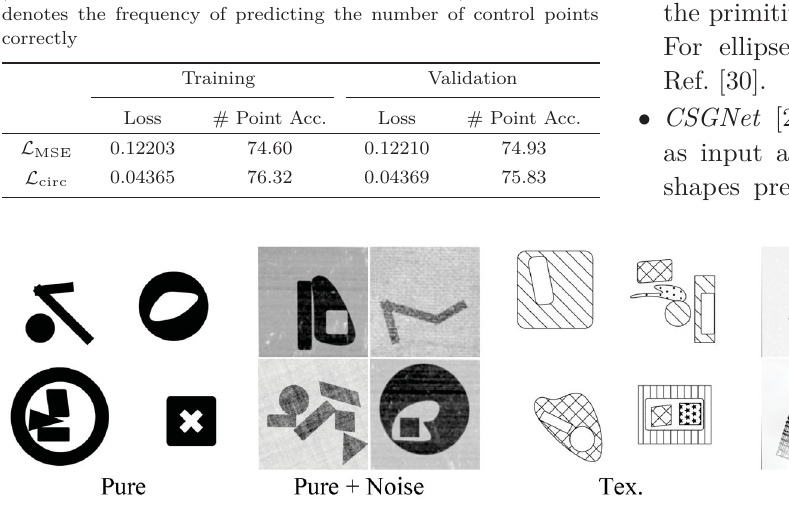
Fig. 3 Examples drawn from our synthetic training dataset. For the Pure dataset, we synthesized simple binary images for training. The Pure+Noise dataset modified the Pure dataset by adding noise and random affine transformations to each image. The Tex. (short for “Textured”) dataset allows testing of the robustness of shape detection methods by adding hatching patterns to the shapes. The Textured+Noise dataset imitates real world hand drawn shape pictures. The Natural dataset imitates colored versions of real world